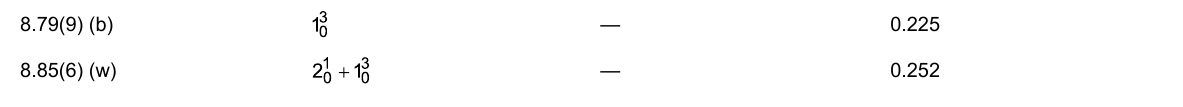
Table 2: Proposed vibrational assignments in the 4.0 − 9.0 eV absorption bands of W(CO) 6 . (b) broad structure; (s) shoulder structure; (w) weak fea- ture. The last decimal of the energy value is given in brackets for these less-resolved features). (continued)